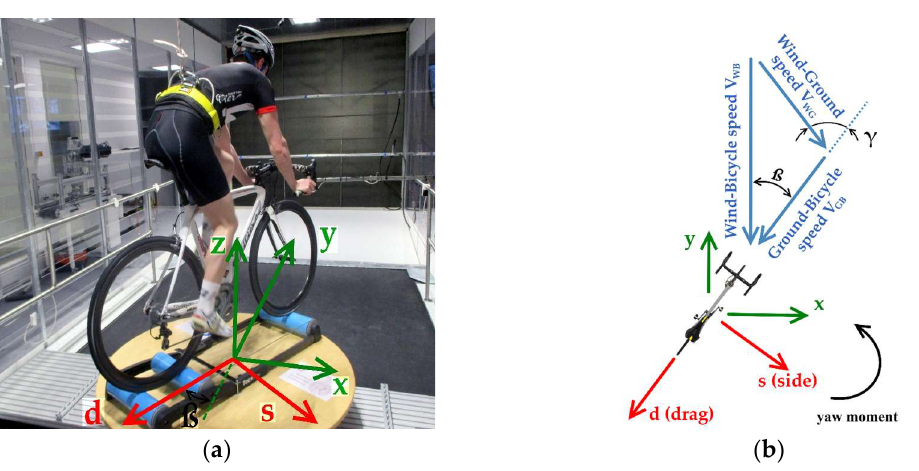
Figure 3. Reference coordinate systems ( a ) in a back-side view during a test and ( b ) in a sketch from a top view with the speed vectors. x, y, z is the absolute coordinate system of the platform, whilst the drag and side axes (d, s) rotate around z-axis (with the variation of the yaw angle ß ) and they are referred to the rider. The angle γ is the absolute angle of the wind referred to the direction of motion. The controlled parameters during the tests were: the wind speed of the tunnel V WB and the yaw angle ß